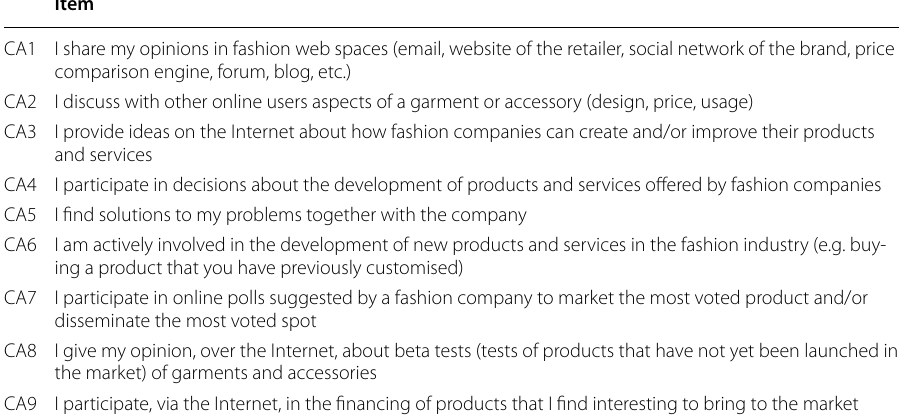
Table 2 Co‑creation activities scale